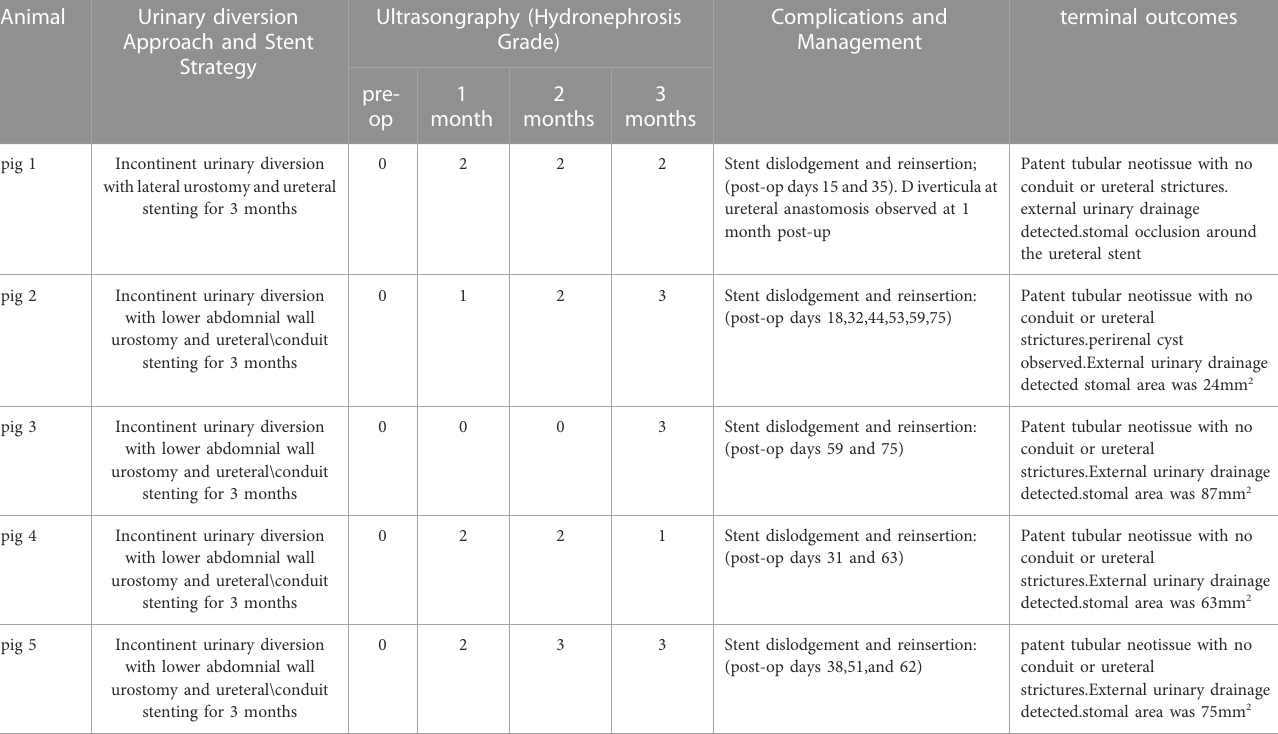
TABLE 1 Surgical Outcomes of Urinary Diversion with BLSF conduits. Representative data from Pigs 1 – 5.